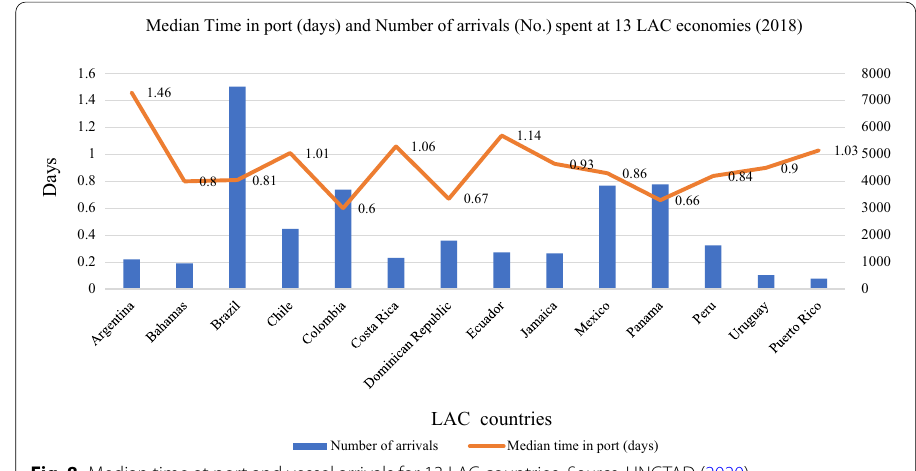
Fig. 8 Median time at port and vessel arrivals for 13 LAC countries. Source : UNCTAD